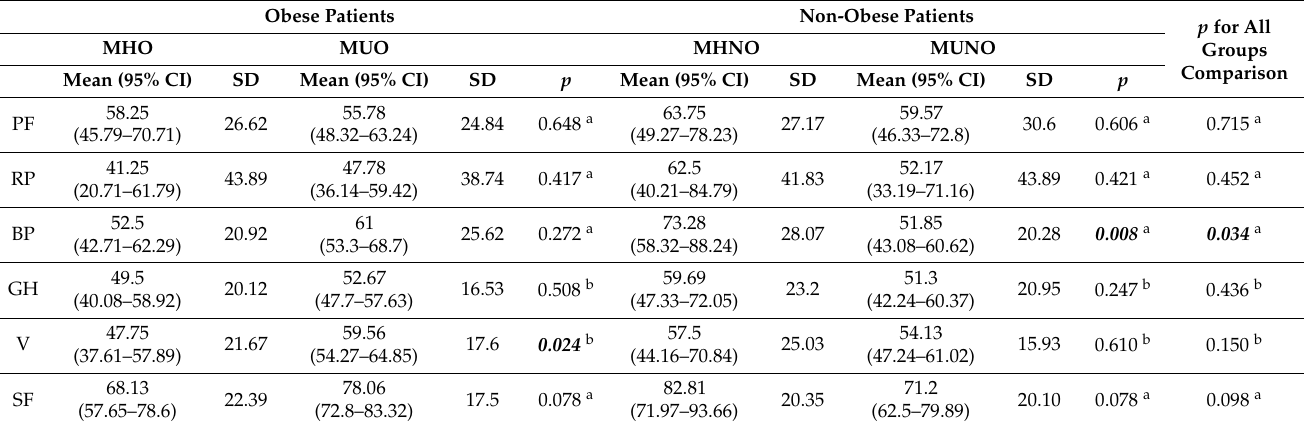
Table 3. Quality of life scales and scores across obesity